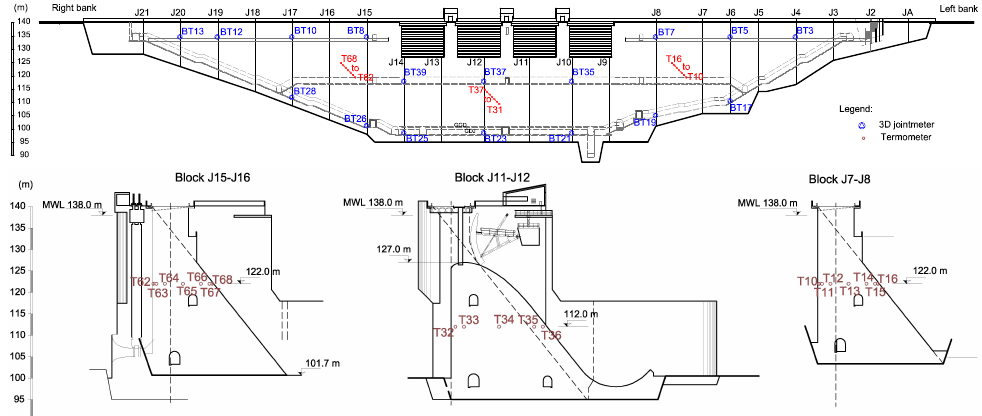
Figure 6. Feiticeiro dam. Thermometers and 3D jointmeters included in the automated monitoring system. Legend: MWL—Maximum reservoir water level.